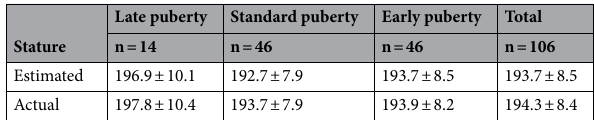
Table 5. Actual and estimated adult stature by maturity stages in male basketball players.